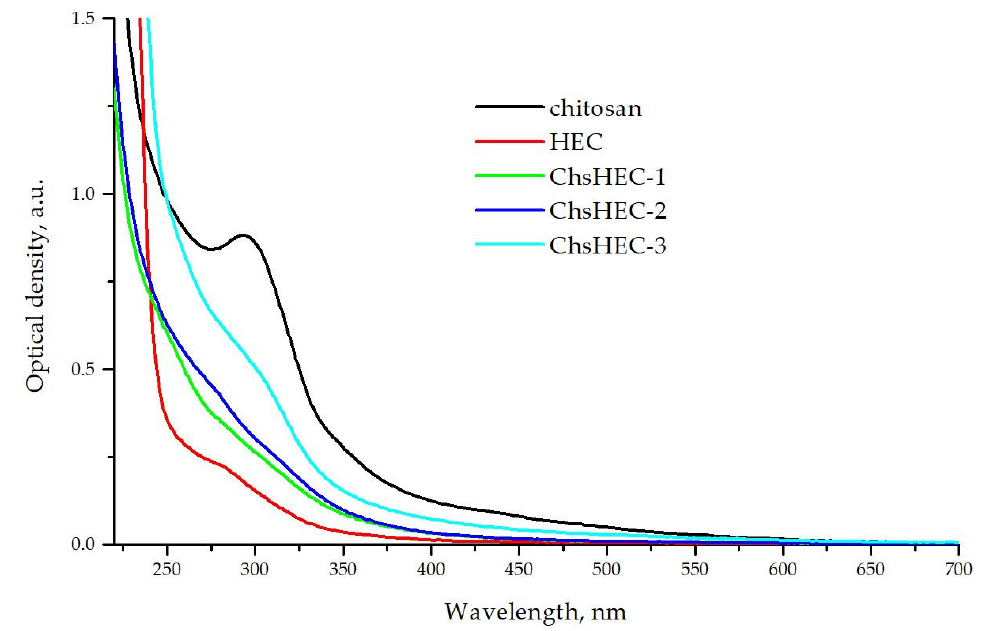
Figure 2. Electron absorption spectra of 1% solutions of initial chitosan in 0.1 M HCl, aqueous solution of initial HEC and water-soluble fractions of ChsHEC samples.